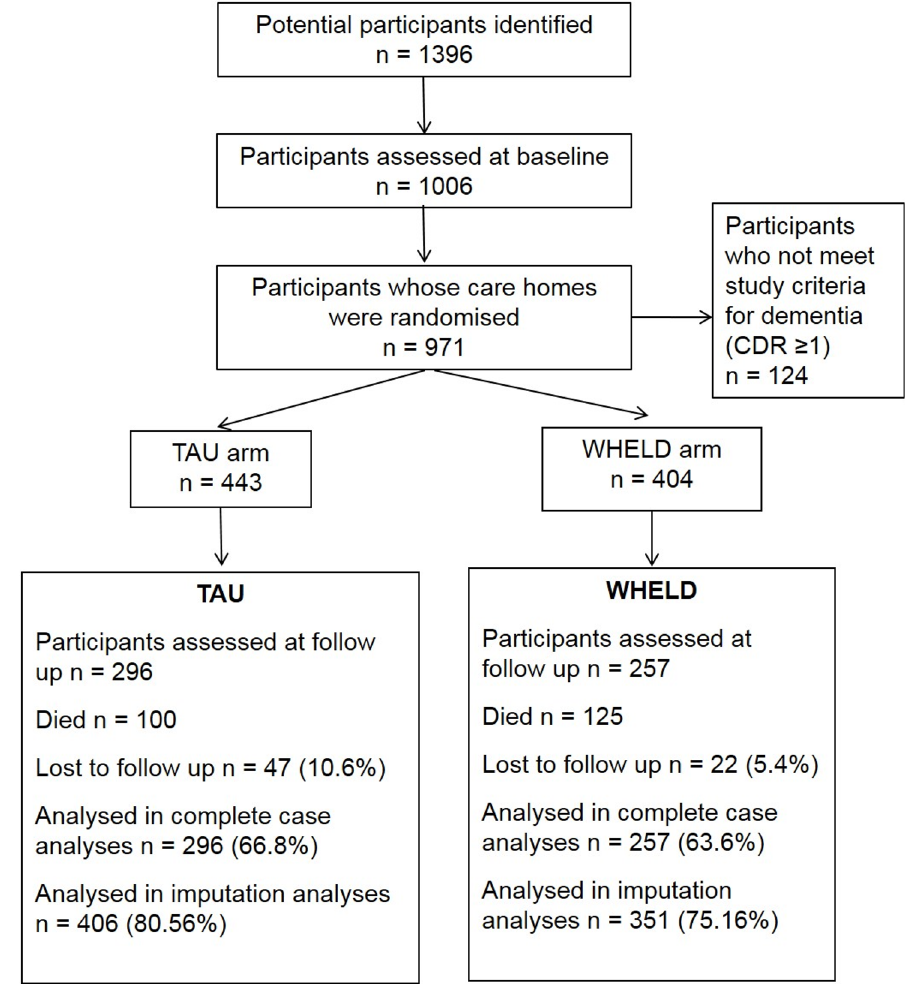
Fig 1. CONSORT chart showing flow of participants through the study. CDR, Clinical Dementia Rating; TAU, treatment as usual.